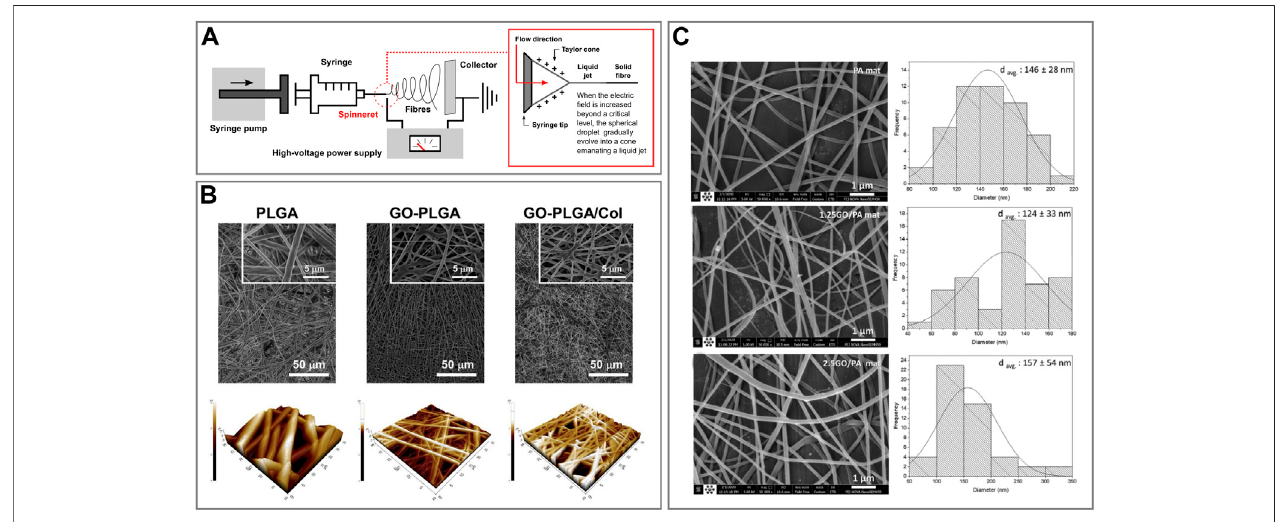
FIGURE 3 | Fibre-like graphene oxide-based biomaterials (A) Schematic representation of an electrospinning setup and phenomenon of electrospinning. (B) FESEM (top) and AFM 3D rendered (bottom) images of PLGA, GO-PLGA and GO-PLGA-Col hybrid fi bres. Reprinted with permission (Lee et al., 2014). (C) FESEM images of PA, 1.25GO-PA, 2.5GO-PA fi bres (left) and histograms of their diameter distribution (right). Reprinted with permission (Bateni and Hashemi Motlagh,